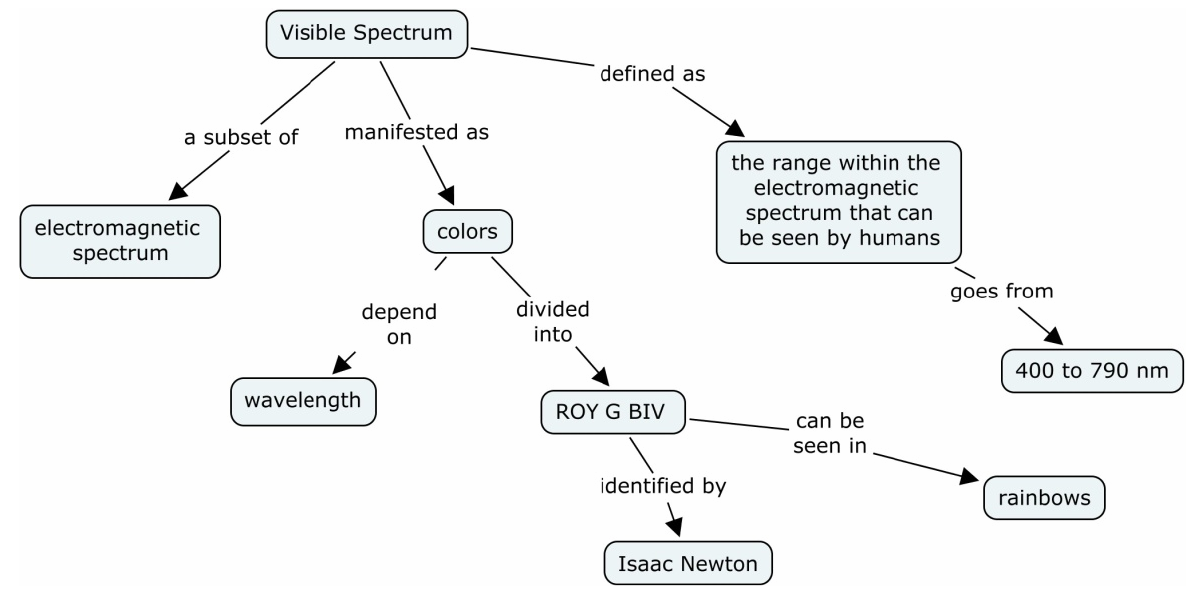
Figure 1. An Example of a Simple Concept